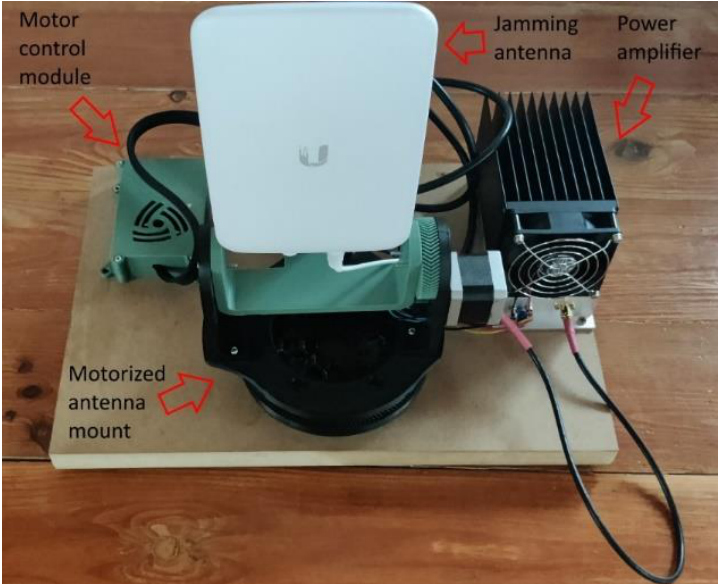
Figure 6. Components used for transmitting the jamming signal.